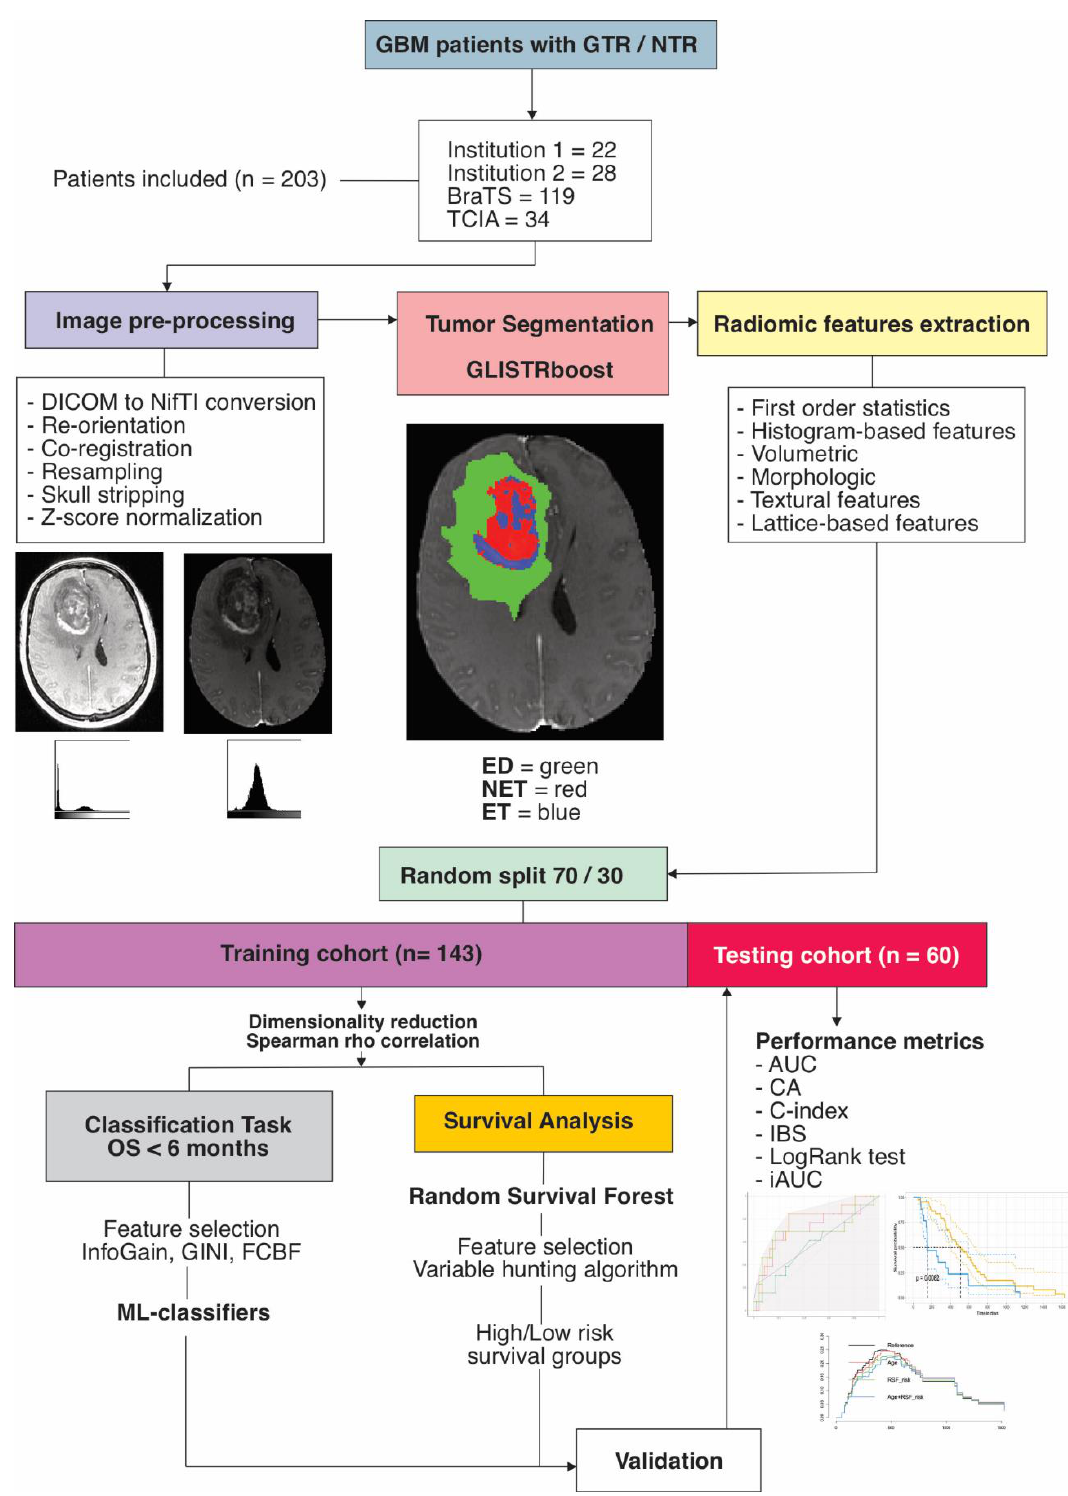
Figure 1. Study workflow. GBM = glioblastoma, GTR = gross-total resection, NTR = near-total resection, BraTS = Brain tumor segmentation challenge 2020, TCIA = The cancer image archive, GLISTRboost = Boosted GLioma Image Segmen- Tation and Registration, ED = edema, NET = nonenhancing tumor, ET = enhancing tumor, OS = overall survival, InfoGain = Information gain, GINI = Gini Index, FCBF = Fast correlation-based filter, ML = machine learning, AUC = area under the curve, CA = classification accuracy, IBS = integrated Brier score, iAUC = integrated AUC.